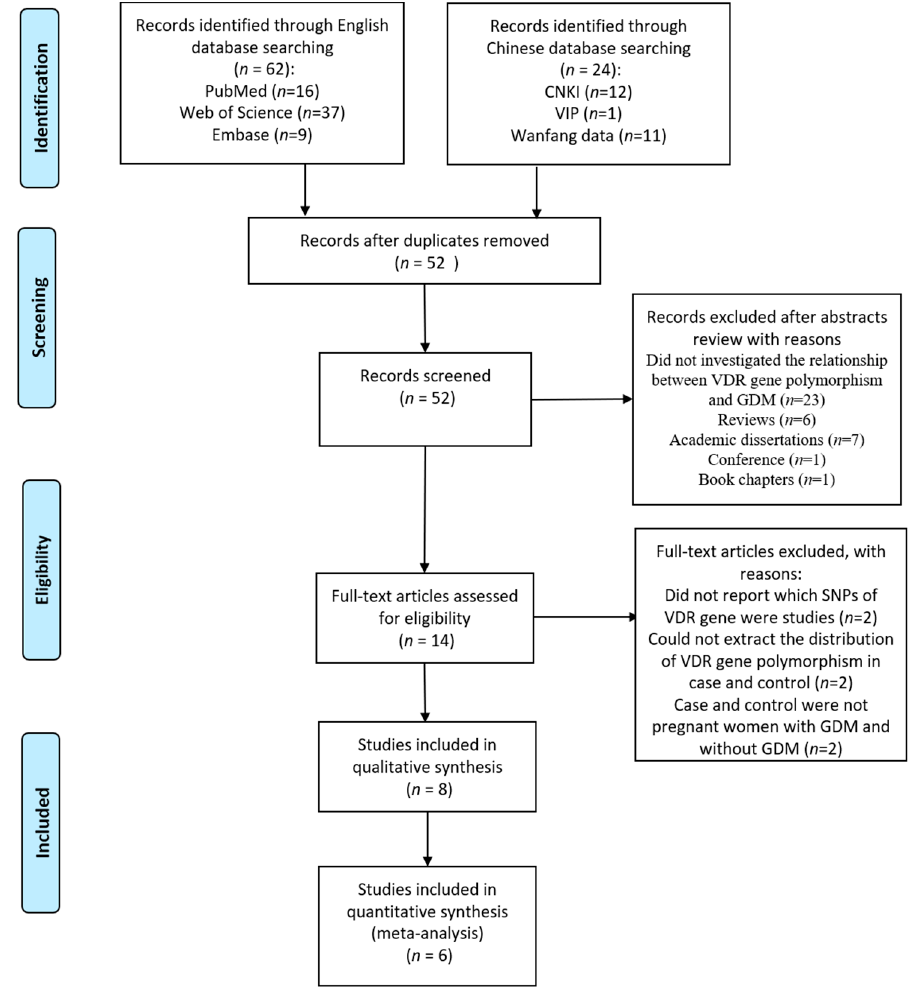
Figure 1. Preferred Reporting Items for Systematic Reviews and Meta-Analyses (PRISMA) flow chart of study identification process.